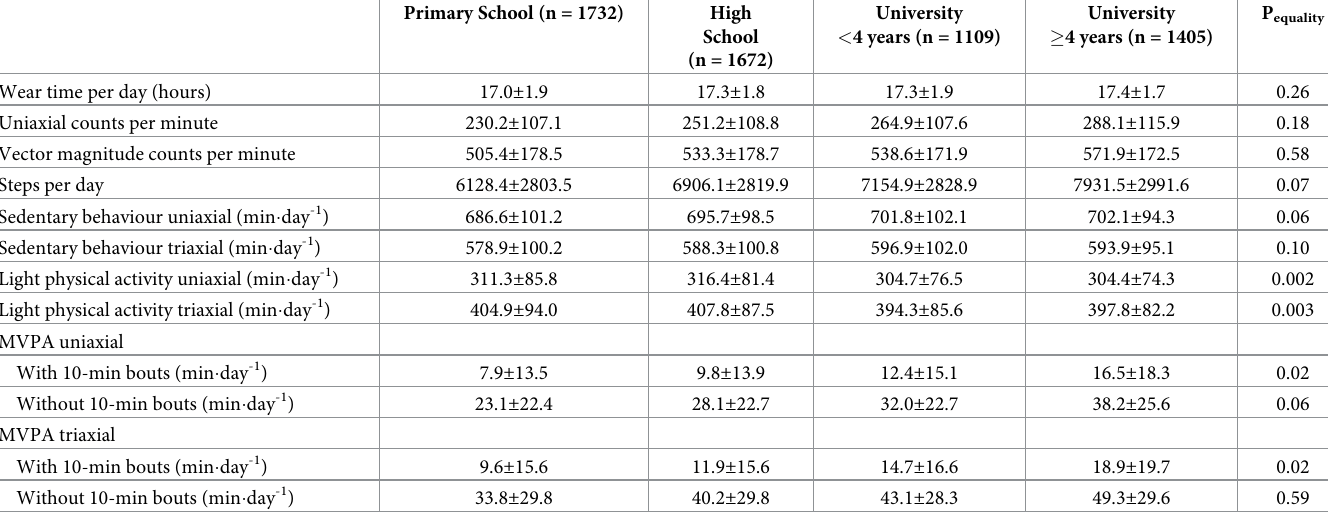
Table 6. Volume measures and intensity specific minutes per day by education. The Troms ø Study accelerometry sample